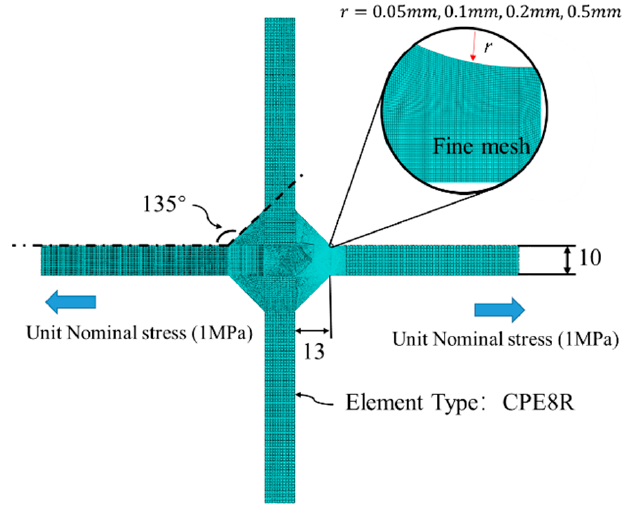
Figure 5. Plane strain model for static analysis, mesh refinement near the weld toe.